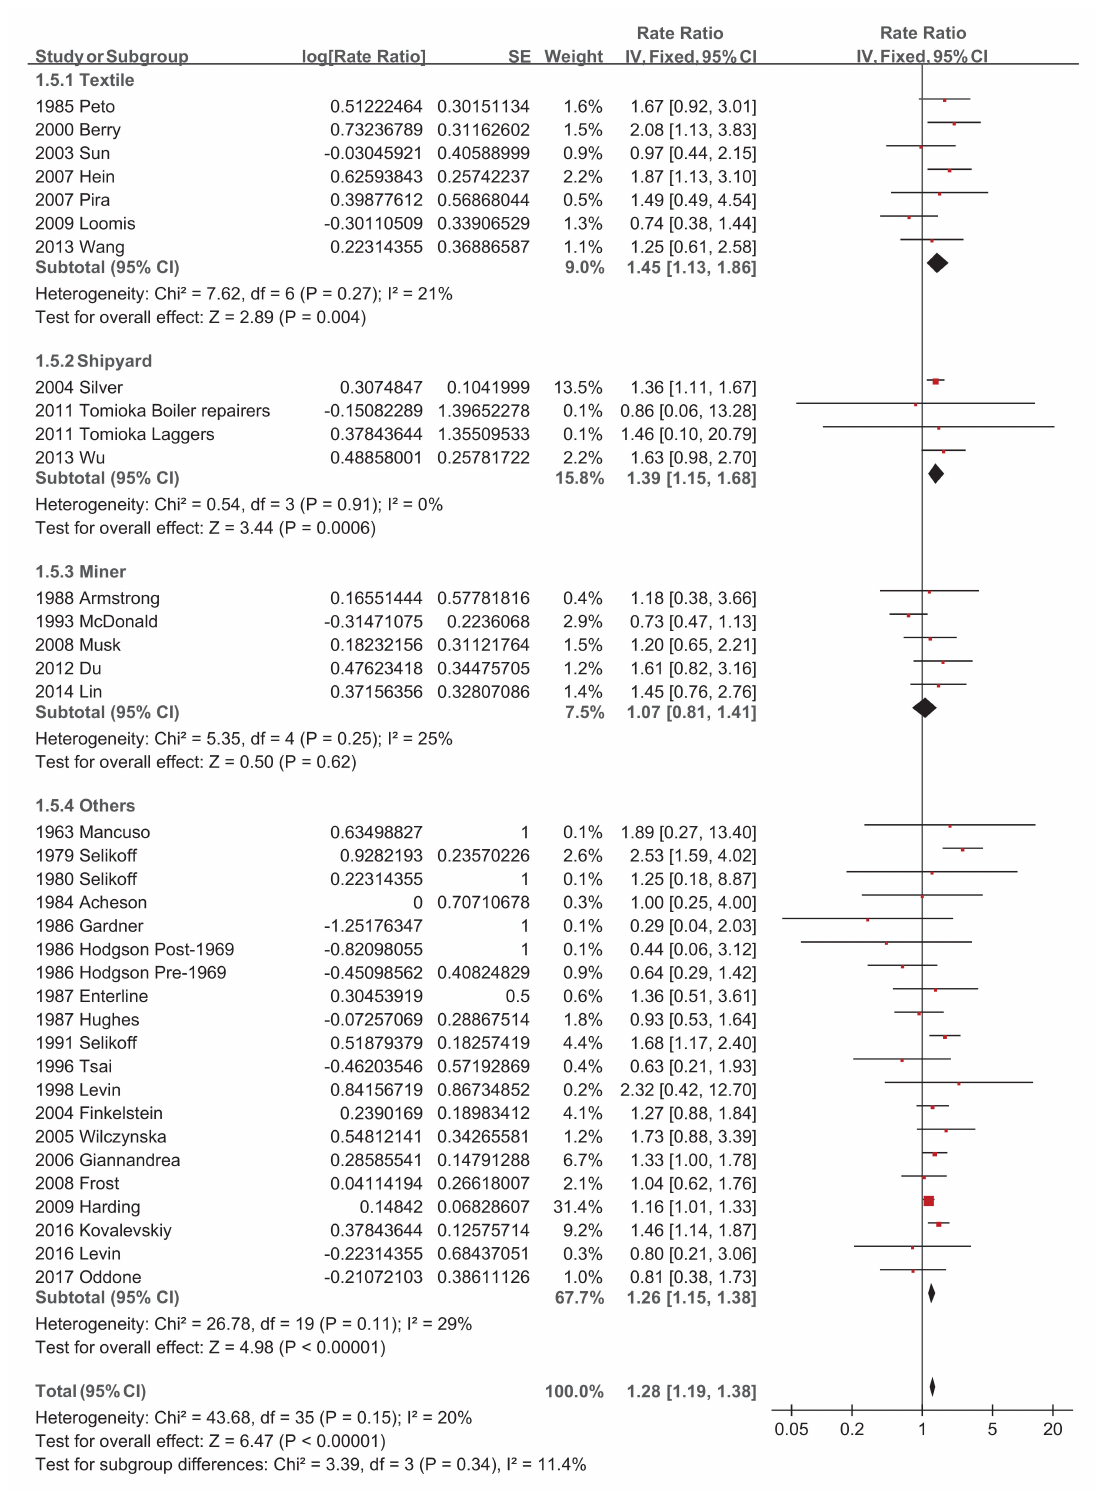
Figure 7. Subgroup analysis of SMRs of esophageal cancer based on industry